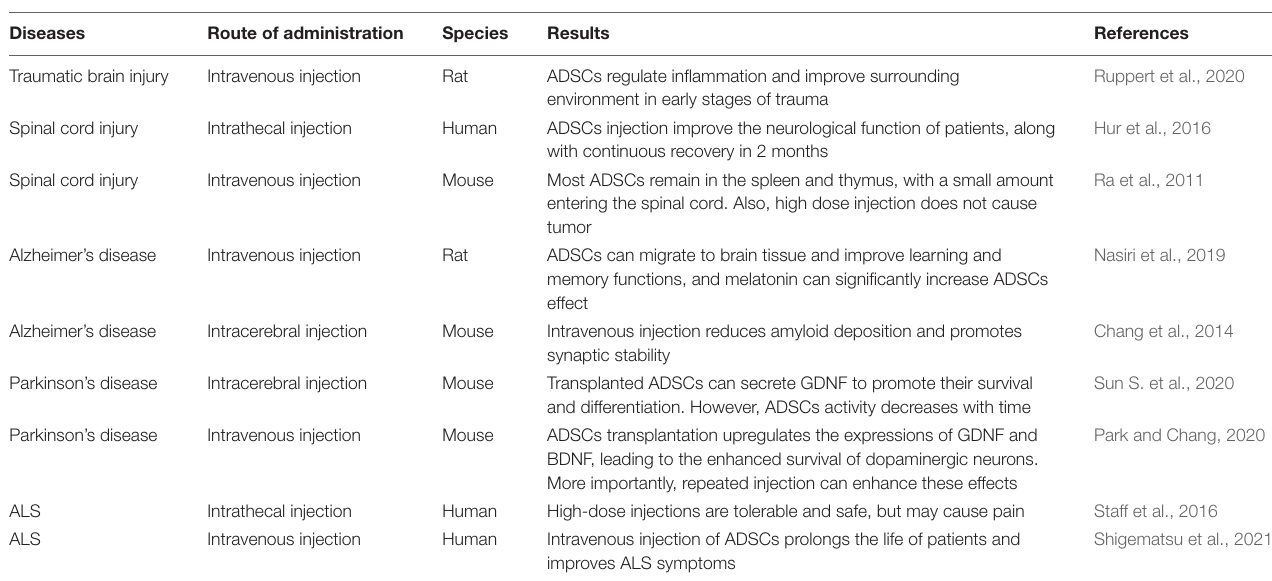
FIGURE 2 | The administration of EVs. EVs delivered intranasally bypass the BBB, and enter the brain directly through the trigeminal and olfactory nerves. Further, some EVs enter the systemic circulation, and permeates the brain through the BBB. TABLE 2 | The different injection methods of ADSCs to ameliorating neurodegenerative